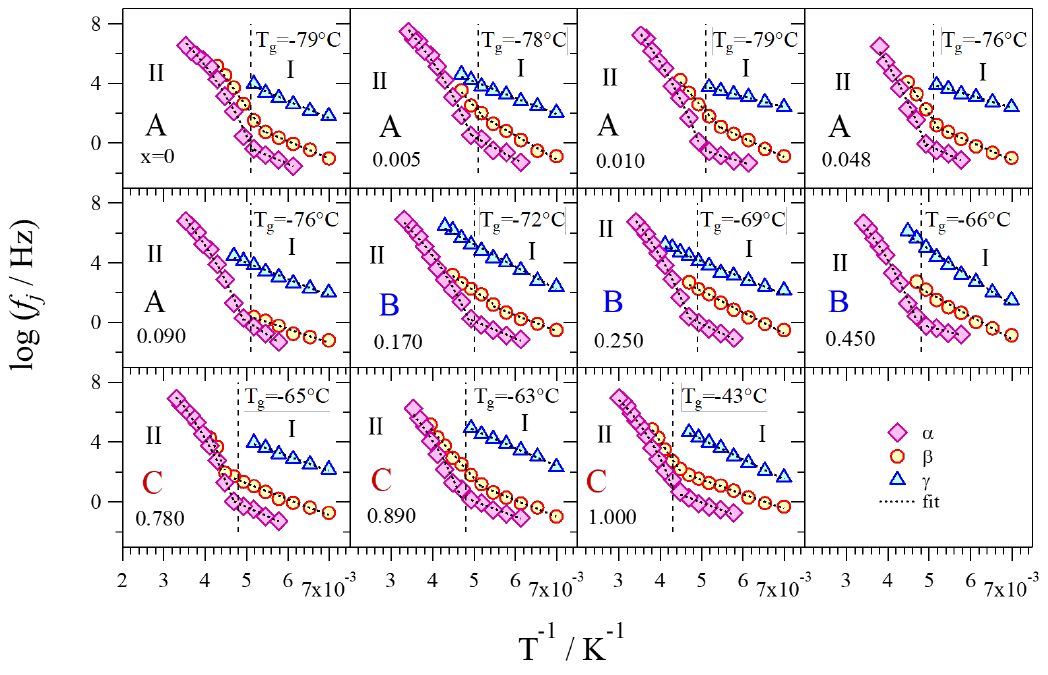
Figure 11. Log f j vs T −1 curves of each dielectric relaxation event for every sample. Regions I and II are divided by the T g of the sample.